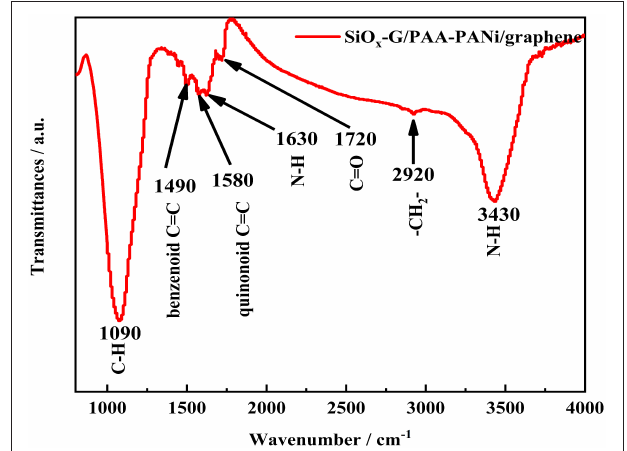
FIGURE 2 | FT-IR image of SiO x -G/PAA-PANi/graphene.